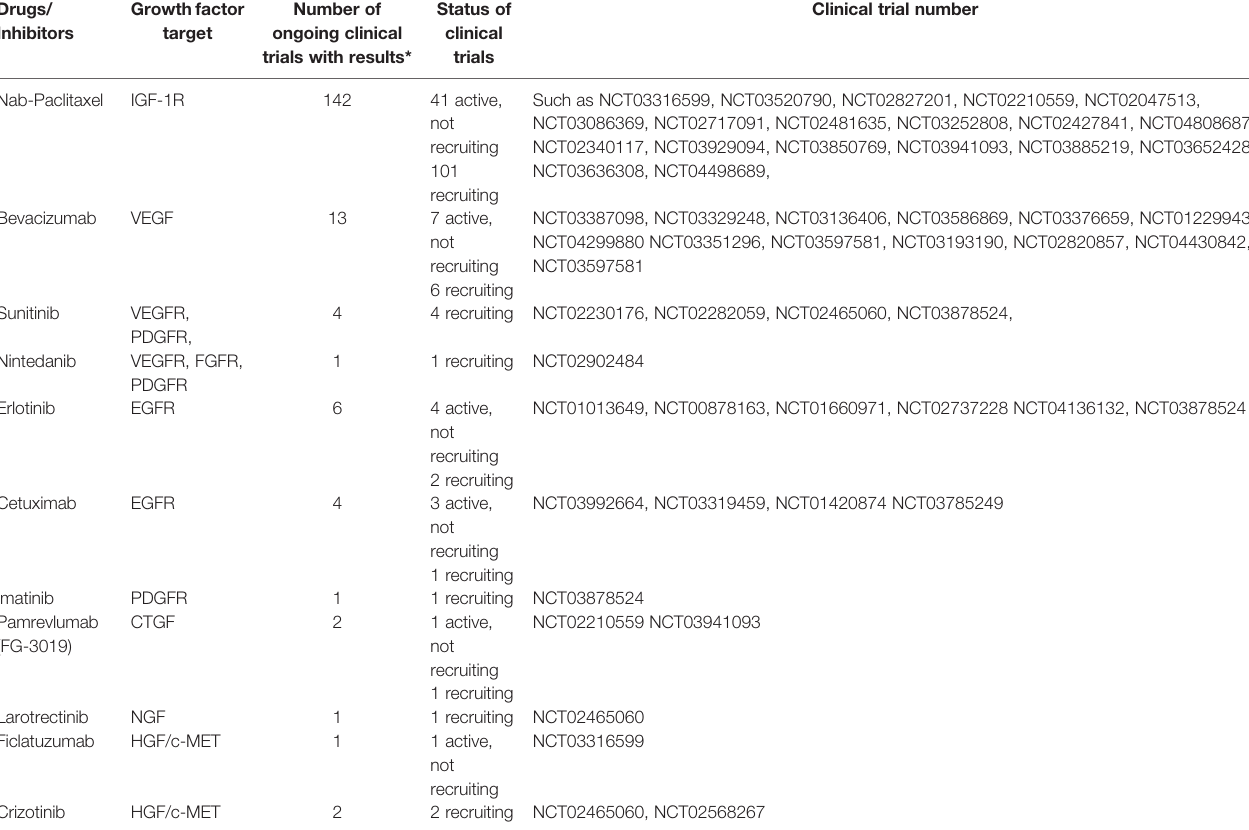
TABLE 1 | Ongoing clinical trials evaluating growth factor inhibition in pancreatic